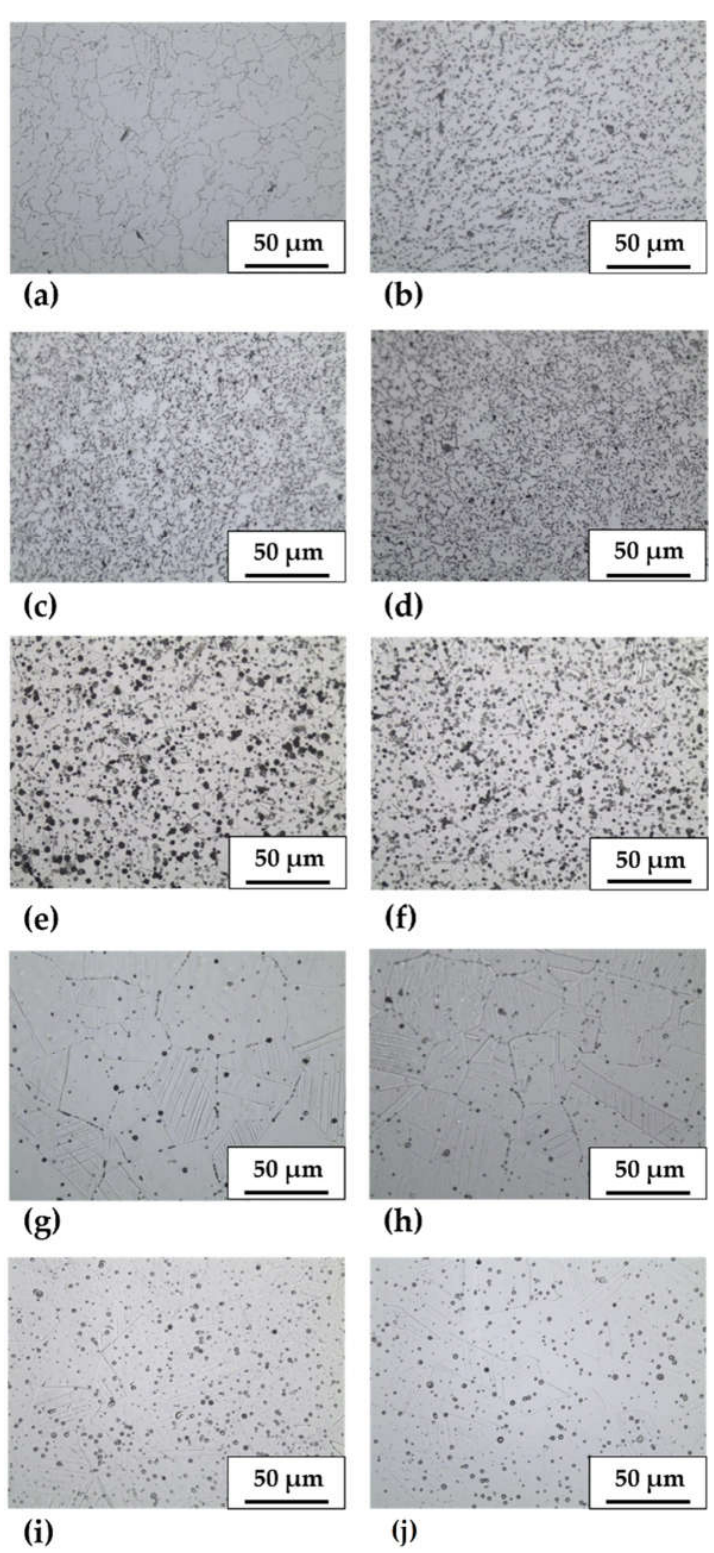
Figure 1. Microstructure of ( a ) AISI 430 drawn finishing, ( b ) AISI 430 ground finishing, ( c ) AISI 430F drawn finishing, ( d ) AISI 430F ground finishing, ( e ) AISI 303 drawn finishing, ( f ) AISI 303 ground finishing, ( g ) AISI 304L drawn finishing, ( h ) AISI 304L ground finishing, ( i ) AISI 316L drawn finishing, and ( j ) AISI 316L ground finishing.